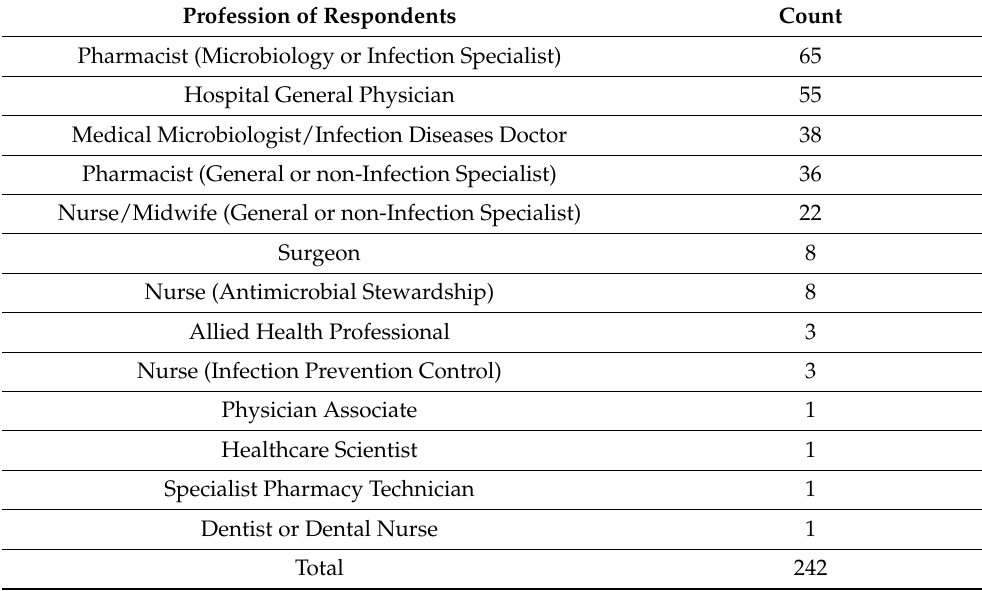
Table 2. Professions of respondents who participated in Delphi (Step Three) 2nd round questionnaire.